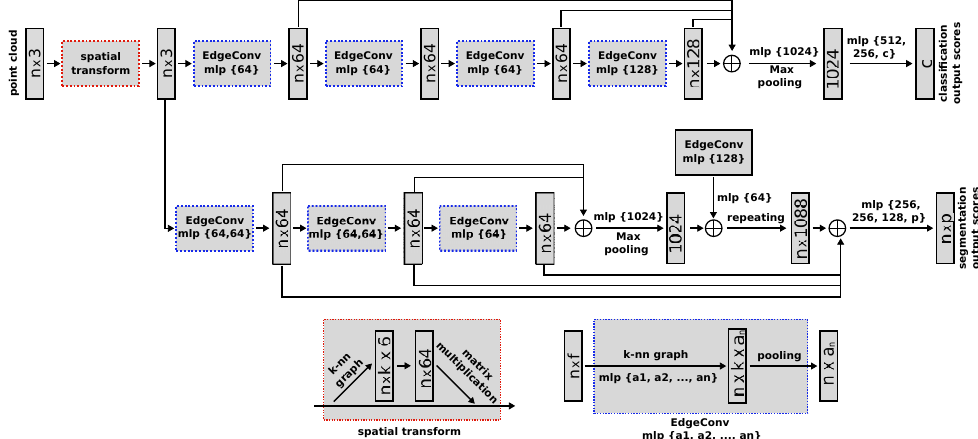
Figure 1. DGCNN architecture. Taken from [47], with permission from author Yue Wang,